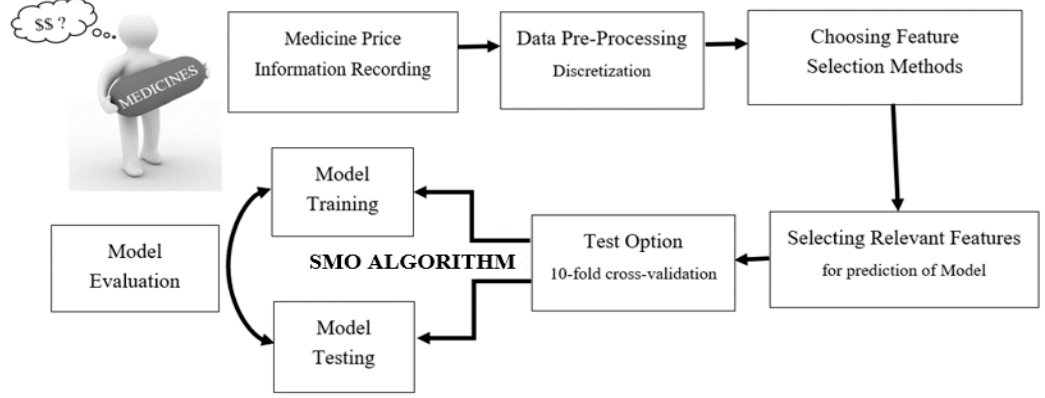
Figure 2. Summarized conceptual framework and research procedure .